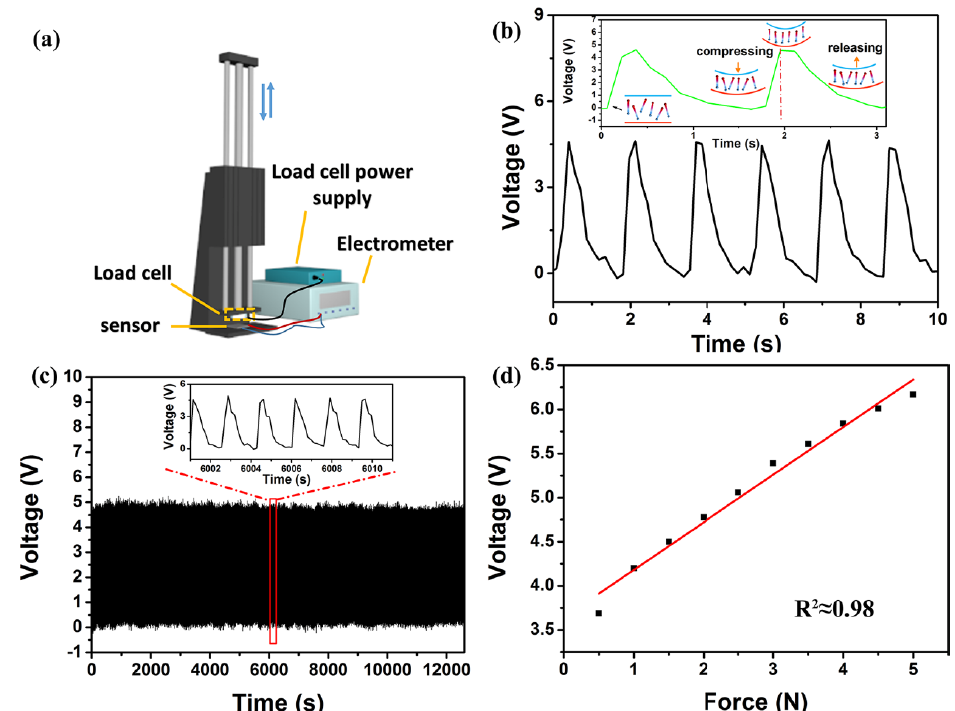
Figure 4. The sensing performance of the piezoelectric pressure sensor based on stretched P(VDF-TrFE)/MWCNT composites. ( a ) Schematic diagram of the designed experimental setup. ( b ) The output voltage response to the external force of 2.5 N with a frequency of 0.6 Hz. The inset shows working mechanism of the piezoelectric pressure sensor. ( c ) The stability measurement over 3.5 h under a 2.5 N stress. The inset shows a magnified 10 cycles. ( d ) The linear relationship between generated voltage and the compressive force in the range of 0.5 to 5.0 N.